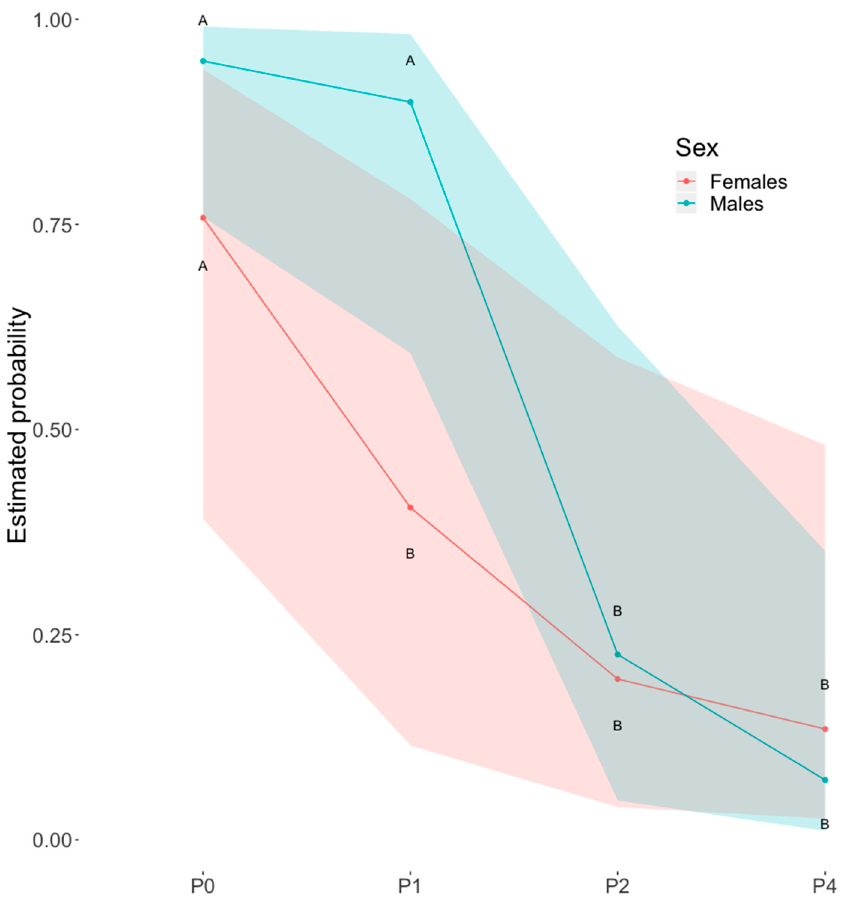
Figure 2. Choices of S − as a function of sex and distance. Generalized Linear Mixed Model (GLMM) mean estimates of the probability of choosing S + as a function of the distance of S − , by intact male and female dogs. Shaded areas represent the lower and upper 95% confidence intervals. Di ff erent capital letters indicate significantly di ff erent probabilities between sexes and di ff erent levels of proximity of S − ( p < 0.05) after sequential Bonferroni corrected post-hoc comparisons.